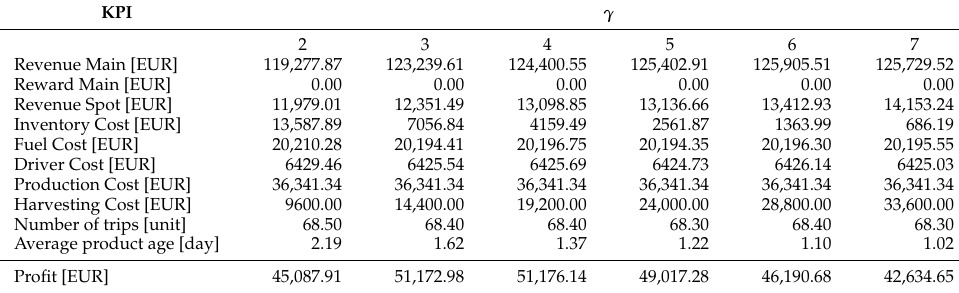
Table 11. Average KPIs for the case of θ = 11 h (company C 1 ). KPI